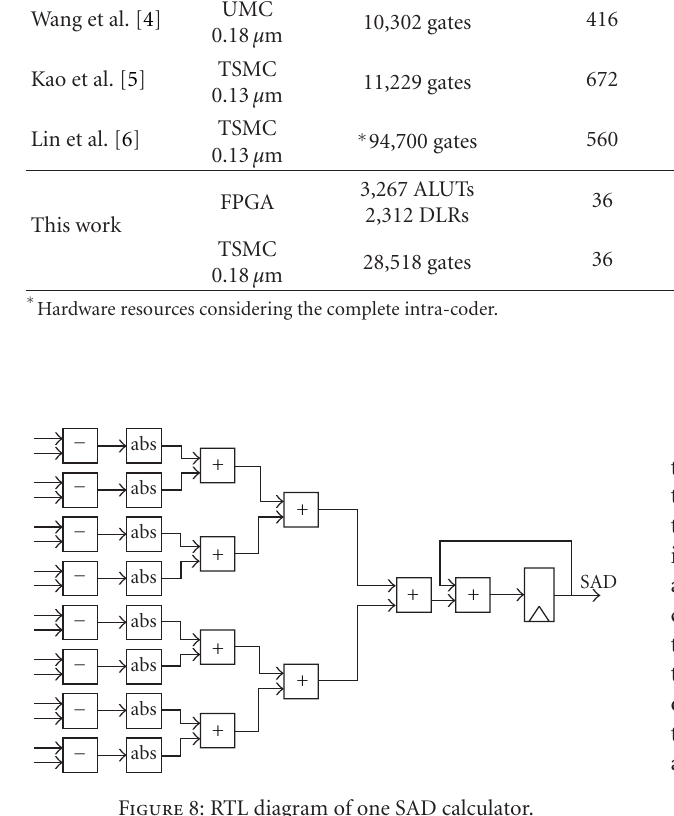
Figure 8: RTL diagram of one SAD